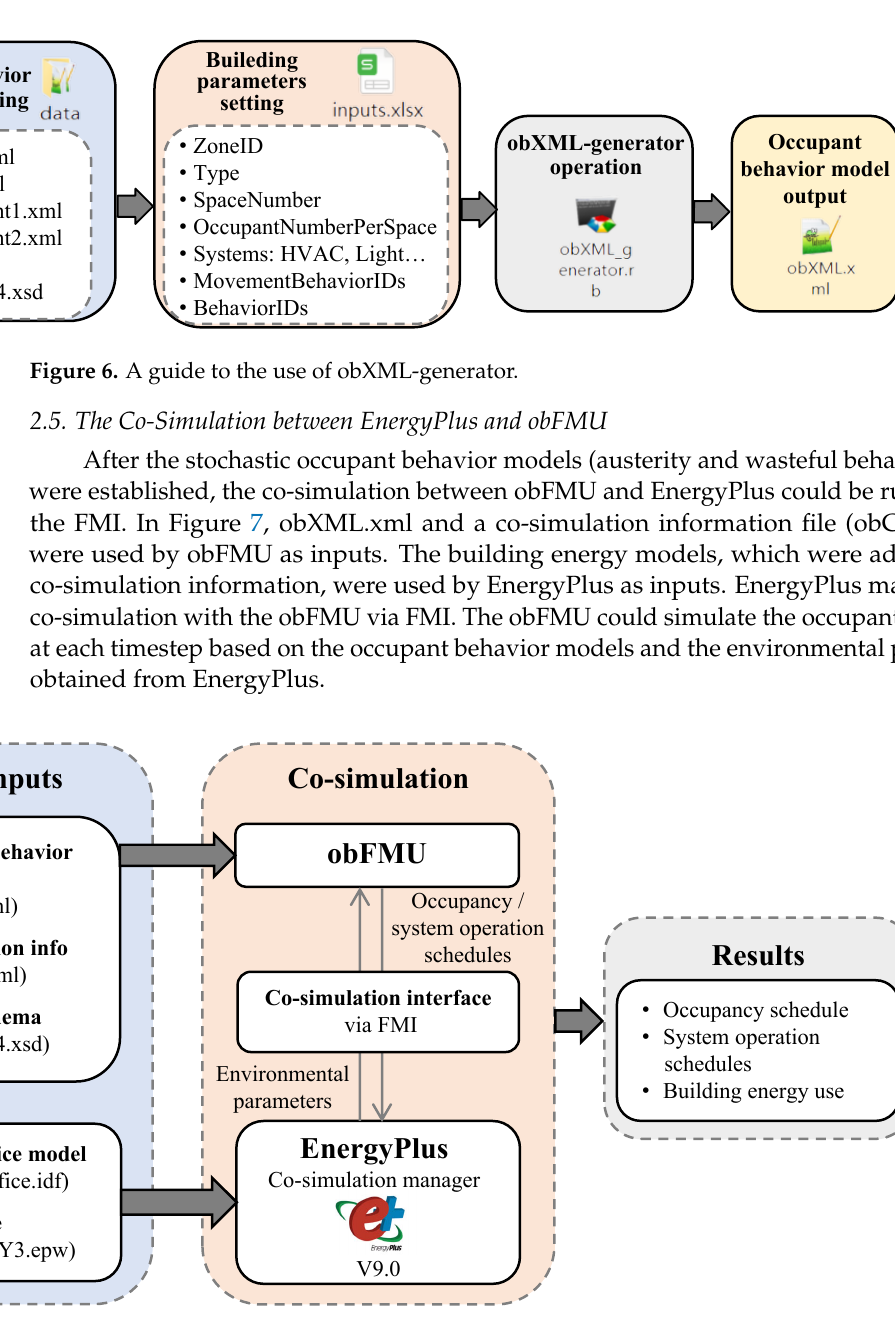
Figure 7. The data flow of the co-simulation between EnergyPlus and obFMU.